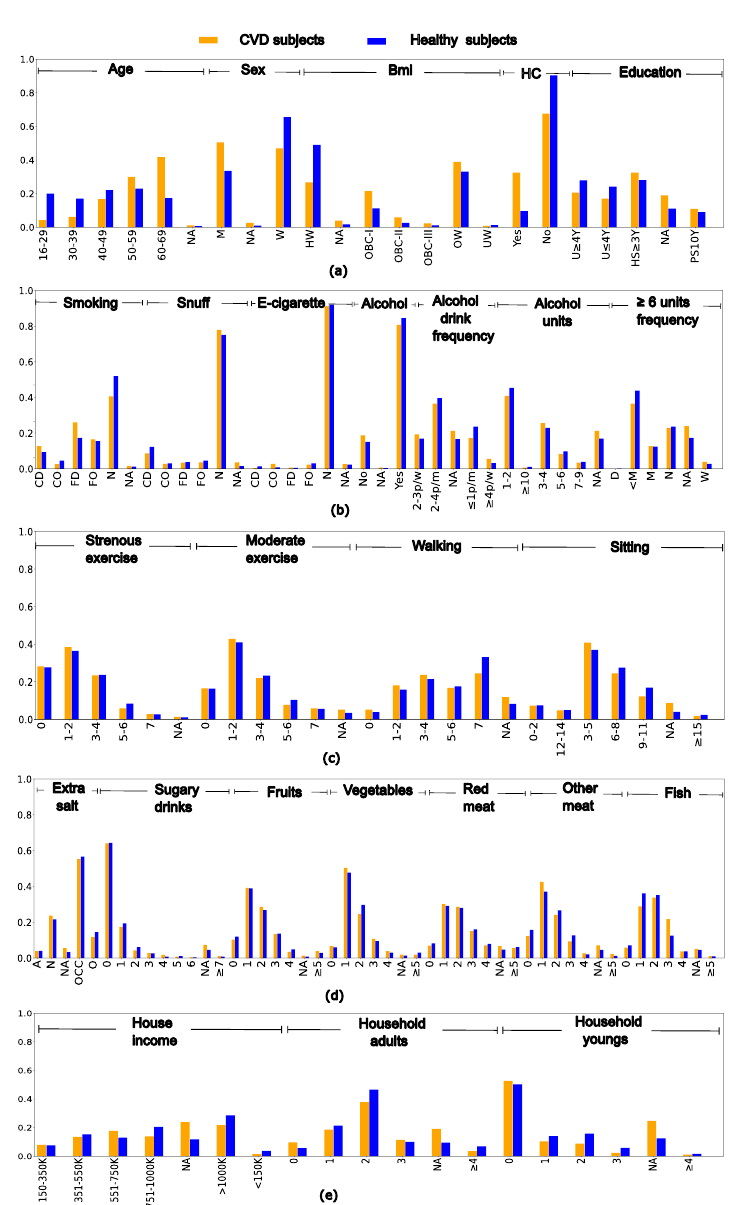
Figure 1. Profiles for healthy and CVD individuals considering: ( a ) background; ( b ) substance use; ( c ) PA; ( d ) dietary intake; and ( e ) income